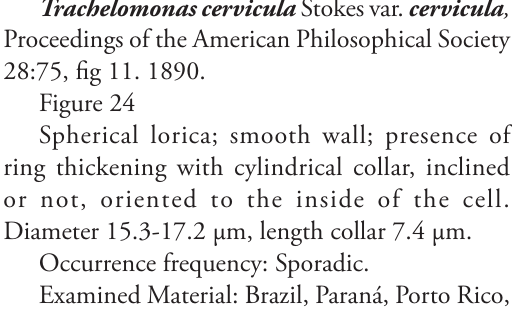
Elliptic-elongated loric; wall punctuated and ornamented with long spines, distributed irregularly throughout the cell; flagellar pore with finite annular formed by the fusion of short conical spines. Length 46.9 µm, width 31.6 µm, length spines